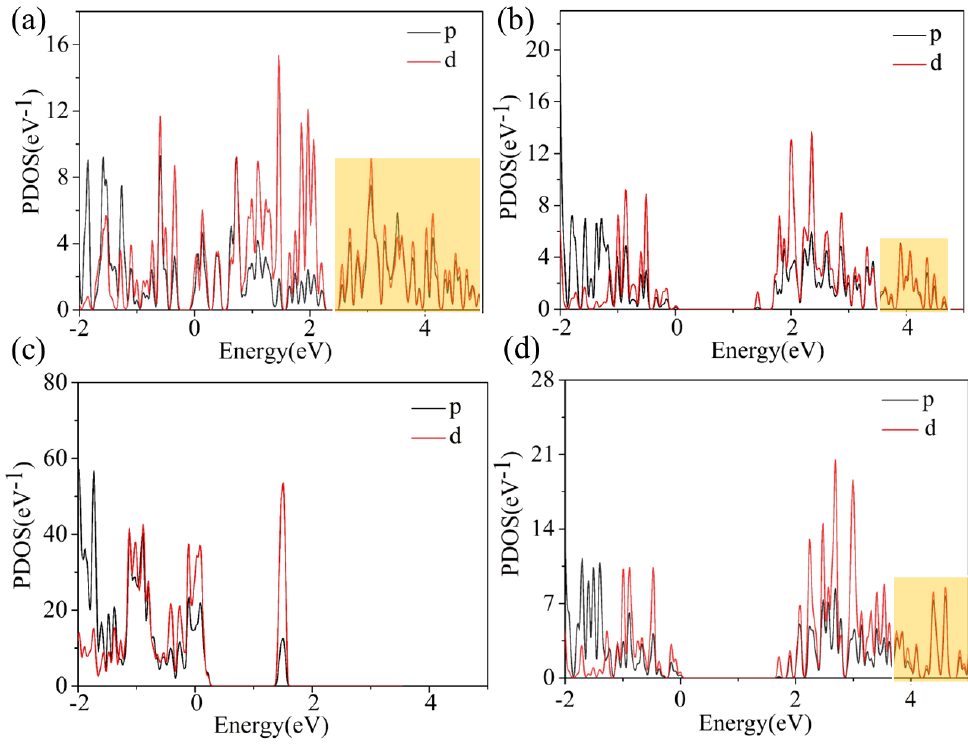
Figure 3. ( a ) PDOS of MoS 2 (space group R 3 (cid:3364) m). The p-d orbital coupling is reflected in the overlap of its PDOS. The area of overlap above the Fermi level is 5.854. ( b ) PDOS of MoS 2 (space group P6 3 /mmc). The area of overlap above the Fermi level is 1.807. ( c ) PDOS of MoS 2 (space group F 4(cid:3364)3 m). The area of overlap above the Fermi level is 0. ( d ) PDOS of WS 2 (space group R 3(cid:3364) m). The area of overlap above the Fermi level is 2.508. The Fermi level is set to 0. The yellow highlighted part indi- cates the overlapping part of the PDOS of the